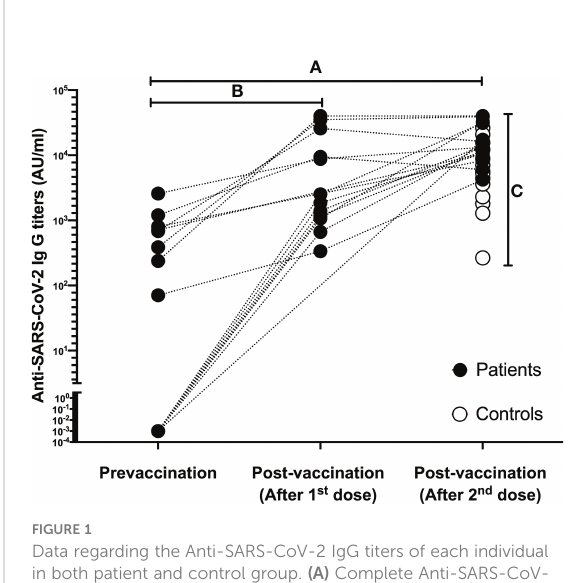
FIGURE 1 Data regarding the Anti-SARS-CoV-2 IgG titers of each individual in both patient and control group. (A) Complete Anti-SARS-CoV- 2 IgG seropositivity was determined in patients after two doses of BNT162b2 vaccination; (B) Anti-SARS-CoV-2 IgG titers increased signi fi cantly after the fi rst dose in patients who were sampled after the fi rst vaccination; (C) After two doses of BNT162b2 vaccination, complete Anti-SARS-CoV-2 IgG seropositivity was also detected in the controls, and the fi nal antibody titers were higher in favor of the patient group.